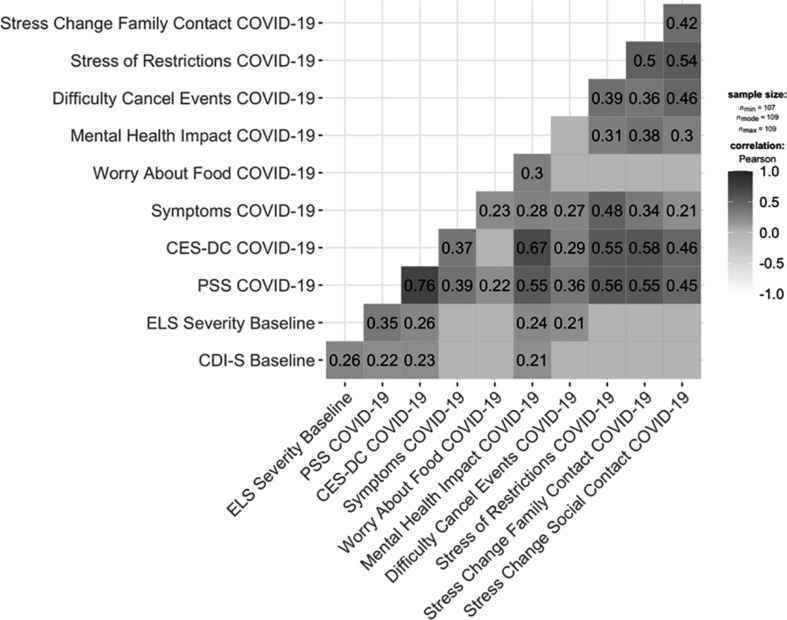
Correlations among Baseline and COVID-19 items/measures assessed in this study. CDI-S, Children’s Depression Inventory; ELS Severity, early life stress; PSS, Perceived Stress Scale; CES-DC, Center for Epidemiologic Studies Depression Scale for Children. Content of COVID-19 items: Symptoms: self-reported fever, cough, shortness of breath, sore throat, fatigue, loss of taste or smell; Worry About Food: “did you worry whether your food would run out because of a lack of money?”; Mental Health Impact: “During the past two weeks, how worried have you been about your mental/emotional health being influenced by Coronavirus/COVID-19?”; Difficulty Cancel Events: “how much has cancellation of important events (such as graduation, prom, vacation, etc.) in your life been difficult for you in the past two weeks?”; Stress of Restrictions: “how stressful have the restrictions on leaving home been for you?”; Stress Change Social Contact: “how stressful have these changes in your social contacts been for you?”; Stress Change Family Contact: “how stressful have these changes in family contacts been for you?”. Correlations are corrected using False Discovery Rate; only significant correlations are shown.